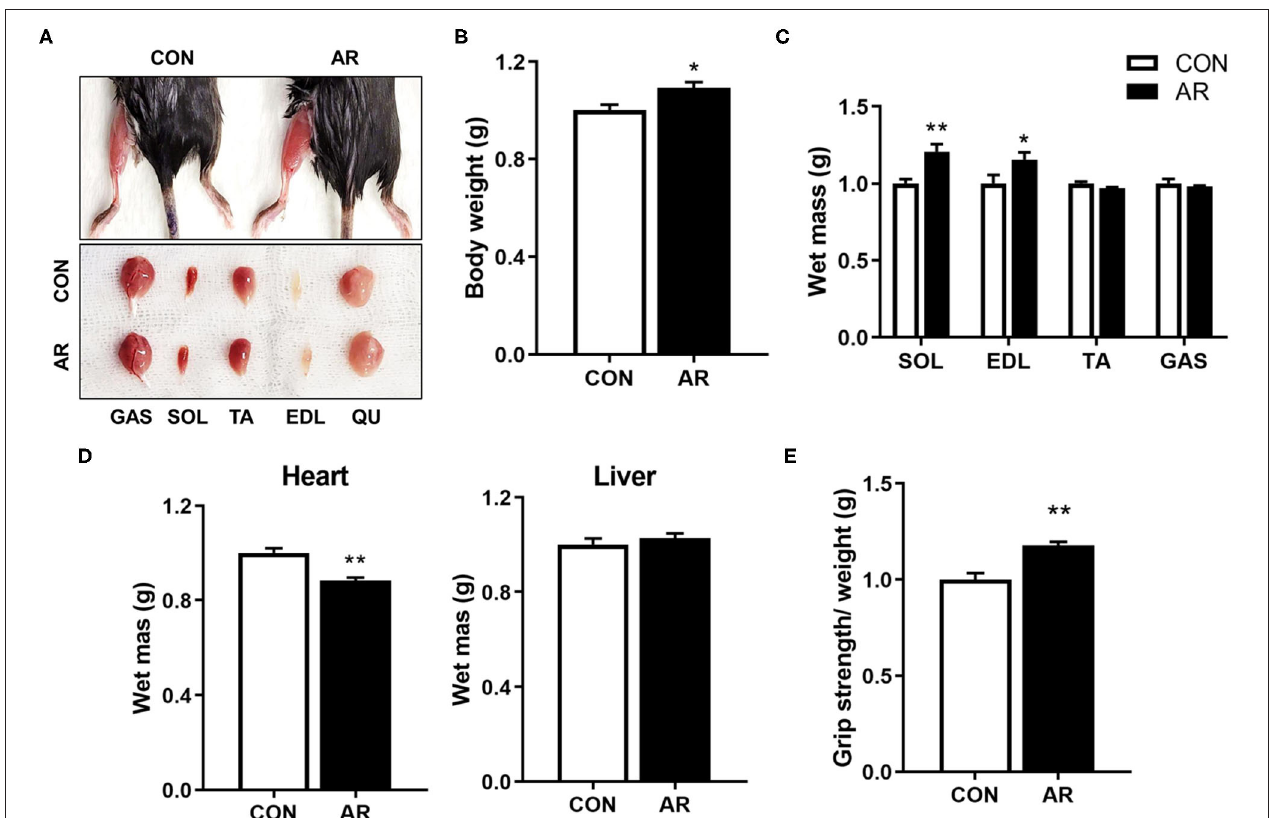
FIGURE 3 | AR enhances muscle mass and strength. (A) Photographs of isolated muscle types from hindlimbs from 8-month-old mice ingested with control or 3.3 mg/kg AR for 8 weeks. (B) Body weight of 8-month-old control-fed and AR-fed mice for 8 weeks. (C, D) Weights of (C) four muscle types and (D) heart and liver from control or 3.3 mg/kg AR-ingested mice for 8 weeks, n = 3. (E) Grip strength depicted as the force (gram) that animals in each group pulled, n = 5. An unpaired two-tailed student’s t -test. The data represent the mean ± SEM, * P < 0.05 and ** P < 0.01. AR, Aronia